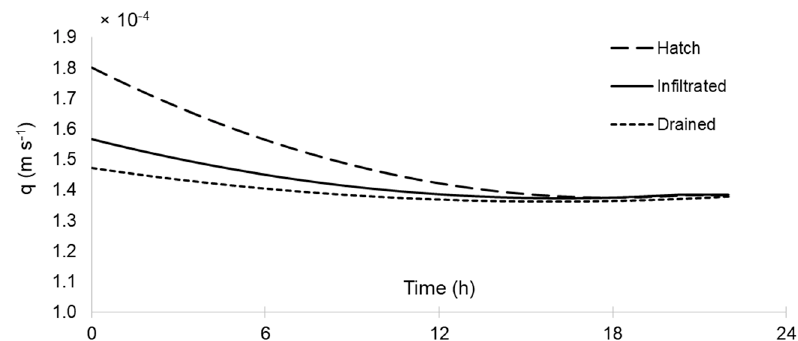
Figure 7. Comparison of water flux rates determined by three approaches. There is a trend to start with higher q values and then the curves tend to stabilize. A high similarity among the curves can be observed once the steady state has been reached.